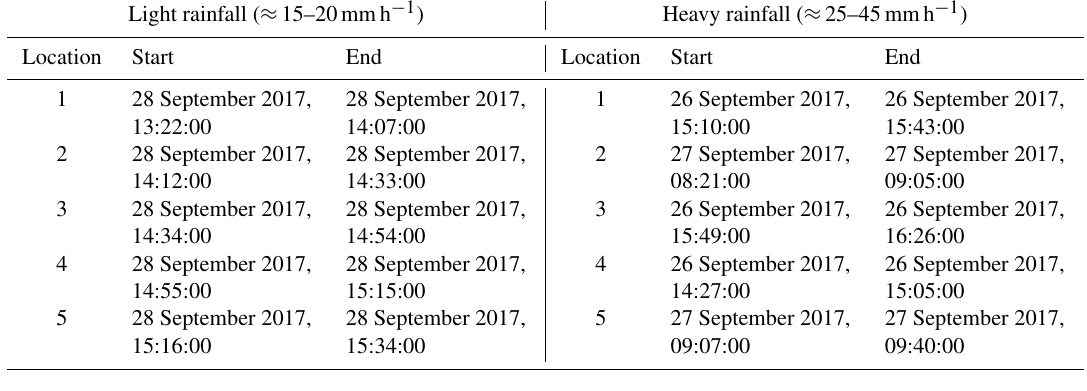
Table 2. Start and end time of tests for each location in both light and heavy rainfall configuration. Local time is used.